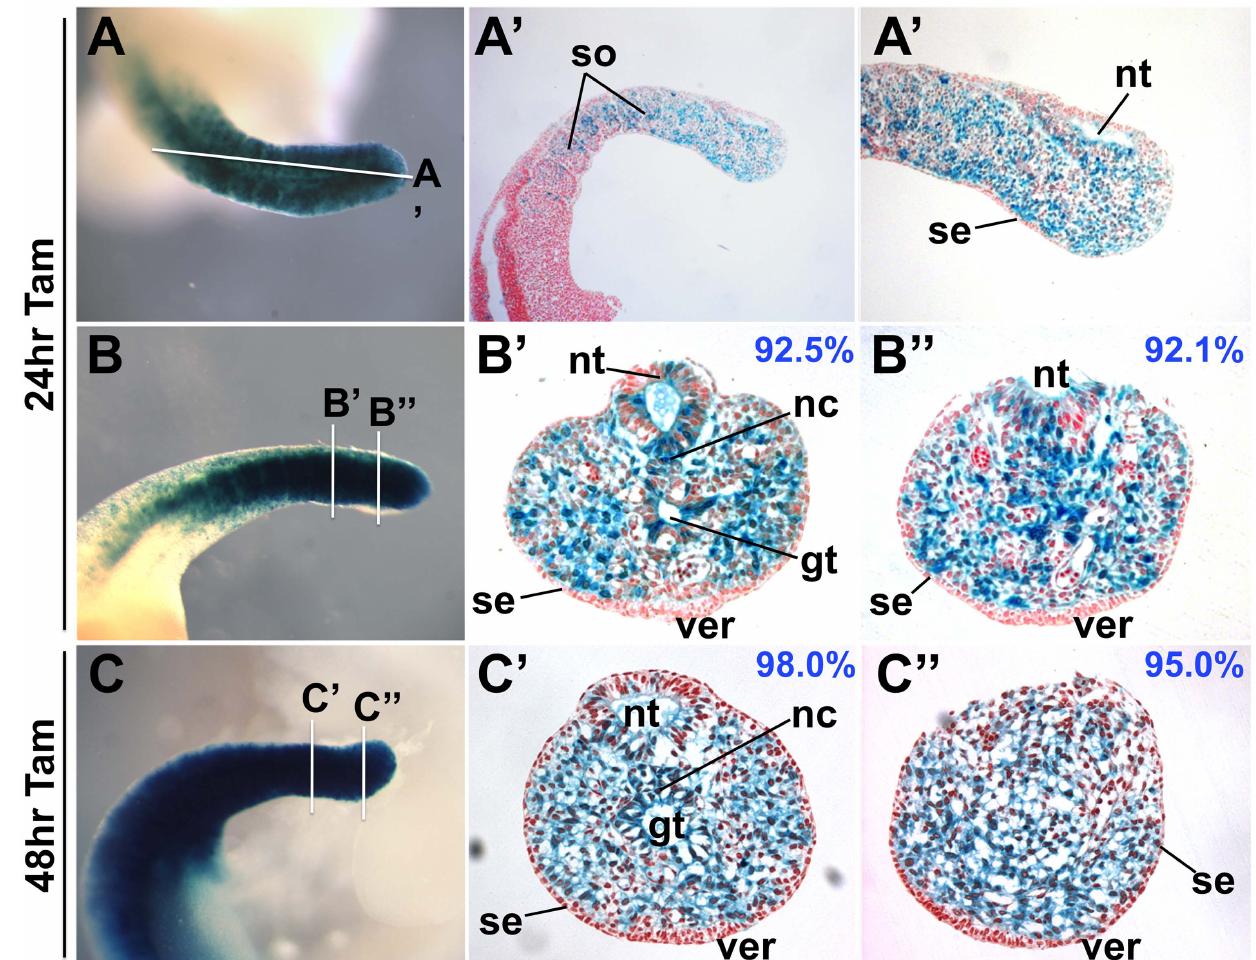
Figure 2. TCreERT2 activation results in high levels of recombination. Sagittal ( A–A’ ) or transverse ( B–B’’, C–C’’ ) sections of an XGal- stained TCreERT2; R26R E10.5 embryo 24 ( A–B’’ ) or 48 hours ( C–C’’ ) after tamoxifen induction, illustrates the extent of recombination (blue cells). Lines in A, B and C illustrate the approximate section locations. Blue numbers indicate the percentage of blue mesodermal cells (excluding blood cells), which increase slightly after a 48-hour induction period from about 92% to 95–98% ( C’ and C’’ ). Note the near absence of blue cells in the surface ectoderm (se). gt, gut tube; nc, notochord; nt, neural tube; so, somites; ver, ventral ectodermal ridge.